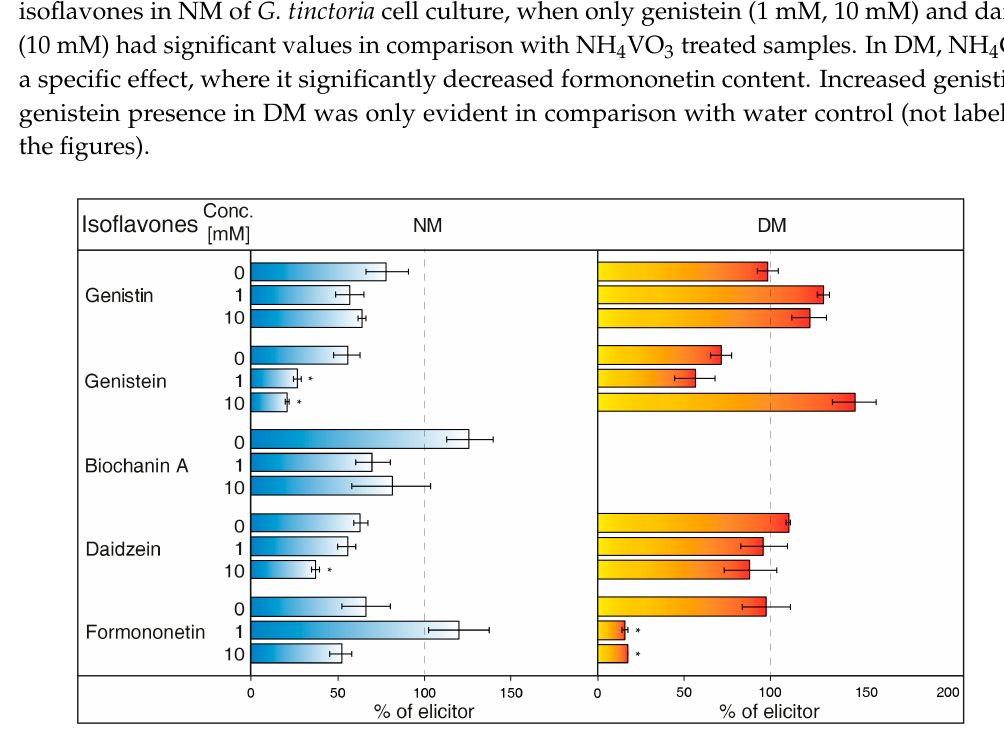
Figure 2. Effects of NH 4 Cl on isoflavone content in nutrient medium (NM) and dry matter (DM) of Genista tinctoria cell culture. Zero concentration of inhibitor represents water control. All bar values were recalculated to a relative 100% isoflavone content in samples with NH 4 VO 3 (1 µ M) after 24 h. Data are mean of three repeats ± SE; (*) represent significant difference ( p < 0.05) between elicited and inhibited or water control samples within Tukey’s